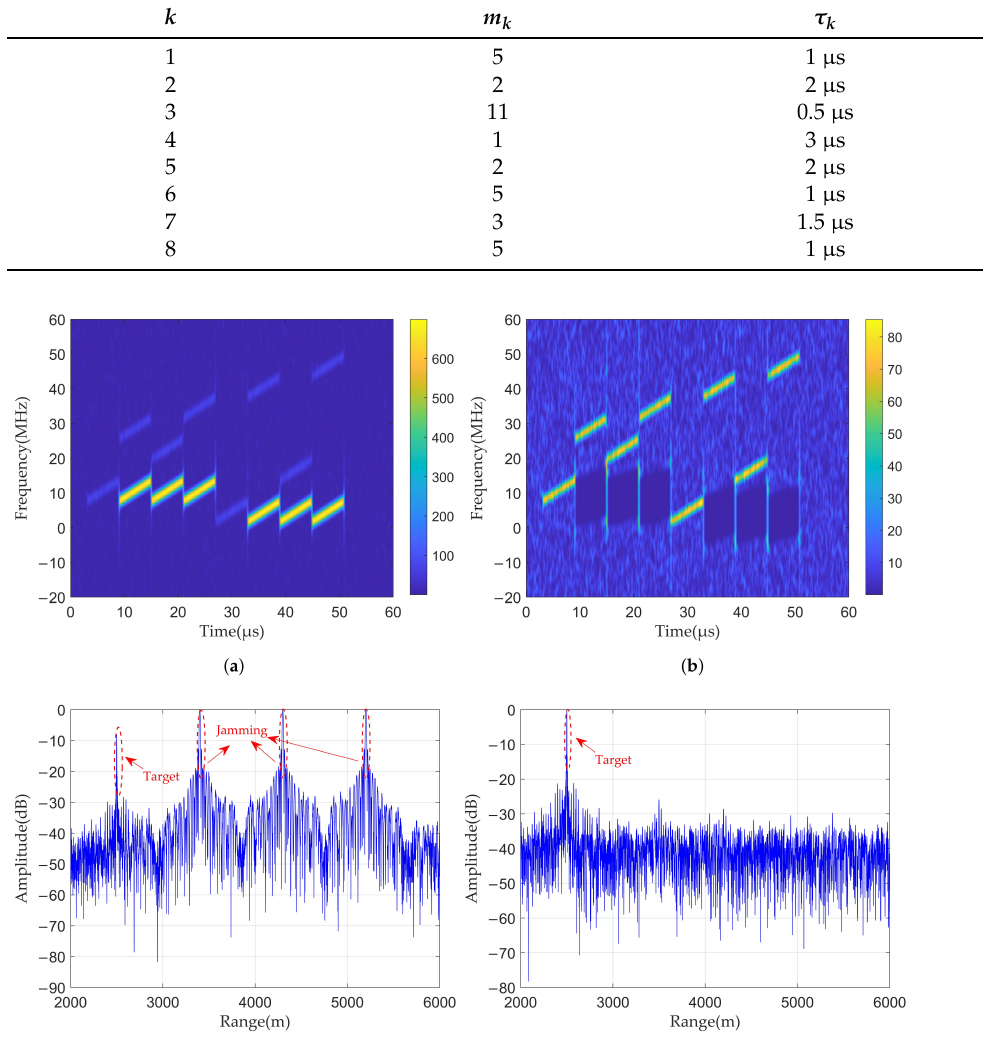
Table 2. Parameters of non-uniform interrupted-sampling repeater jamming.